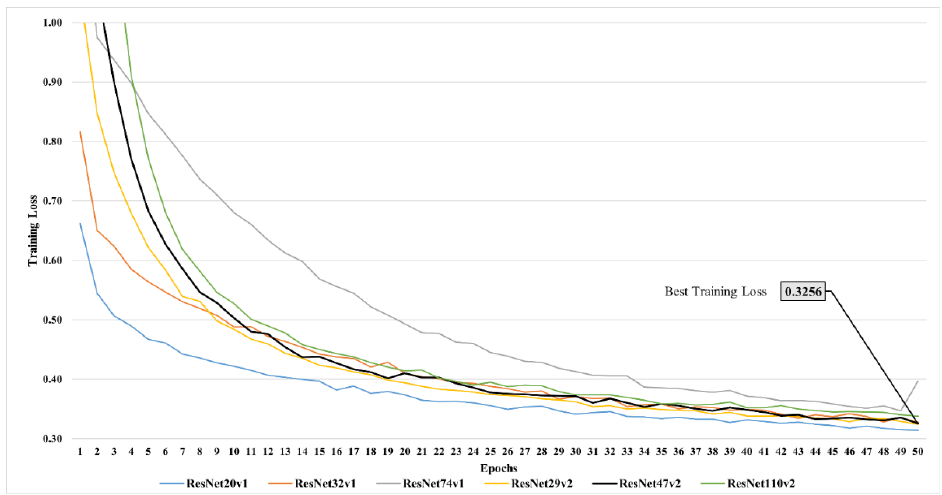
Figure 13. Validation accuracy curves for the various ResNet models.